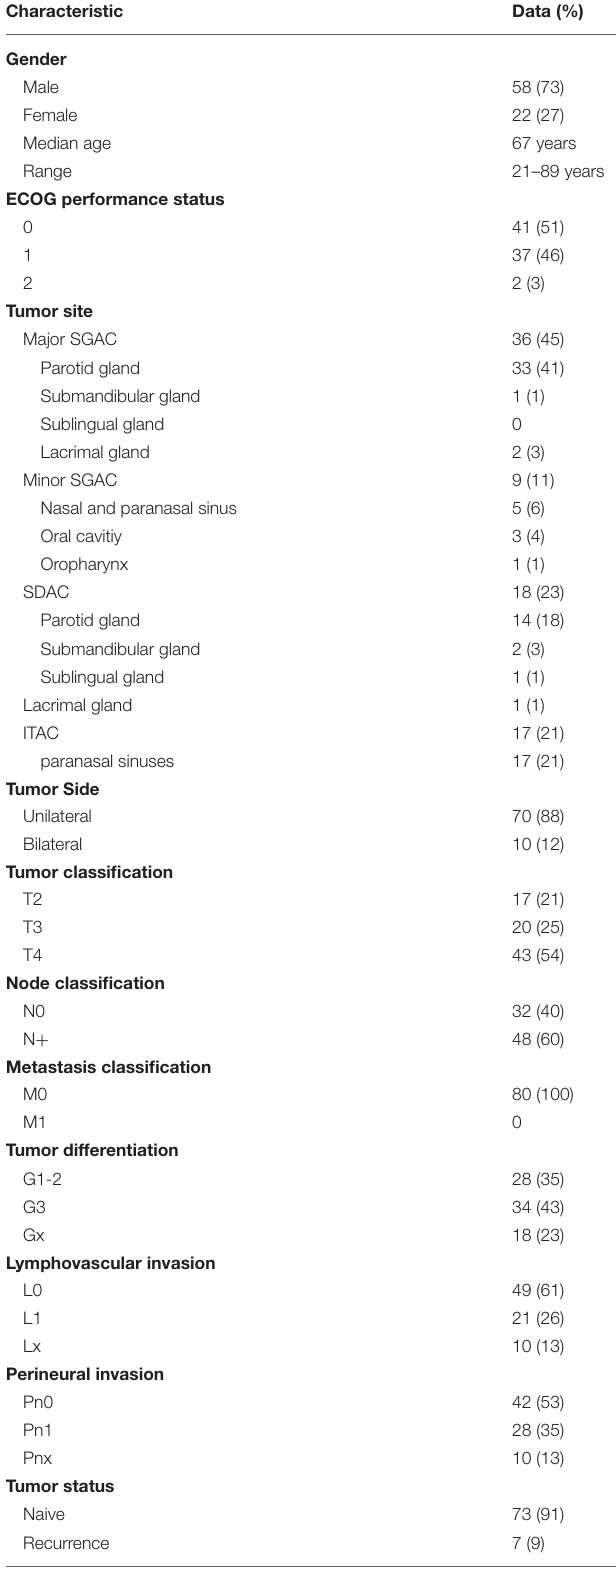
TABLE 1 | Patient and tumor characteristics ( n =